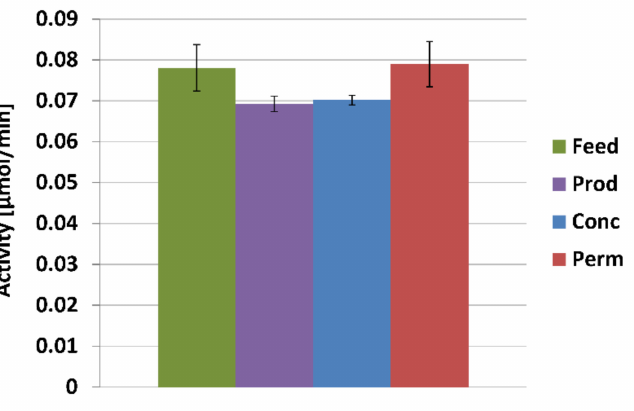
Figure 3. Oxygen consumption in aqueous media with lignosulfonate preparations and active